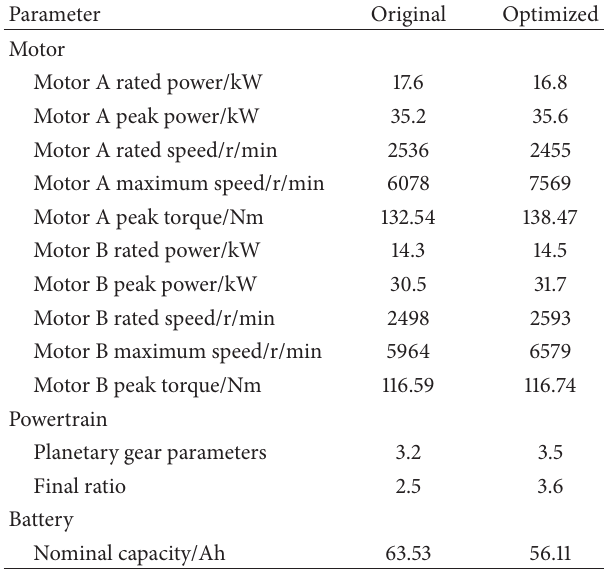
Table 4: Compared parameters before and after